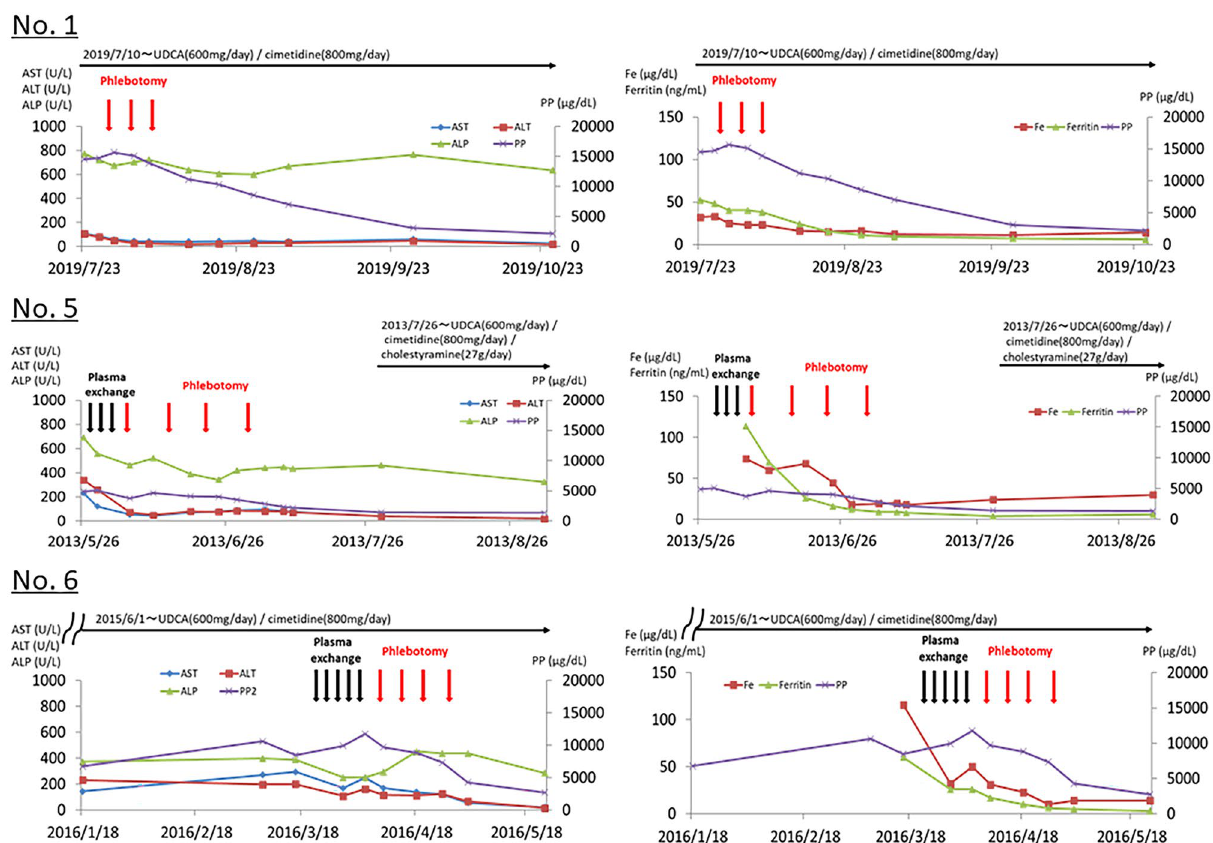
Figure 1. Clinical course after phlebotomy. In patient No. 1, plasma exchange was not performed. Phlebotomy therapy was performed three times (first time, 400 mL; following 2–3 times, 200 mL). In patient No. 5, a plasma exchange was performed five times; however, the serum PP level and liver damage did not improve; thus, the treatment was changed to phlebotomy. Phlebotomy was carefully performed four times in total (400 mL the first time; 200 mL thereafter). In patient No. 6, plasma exchange was performed four times; however, improvement in the serum PP level and hepatitis is not obtained. Thus, the treatment was changed to phlebotomy. Phlebotomy was performed four times in total (400 mL the first time; 200 mL